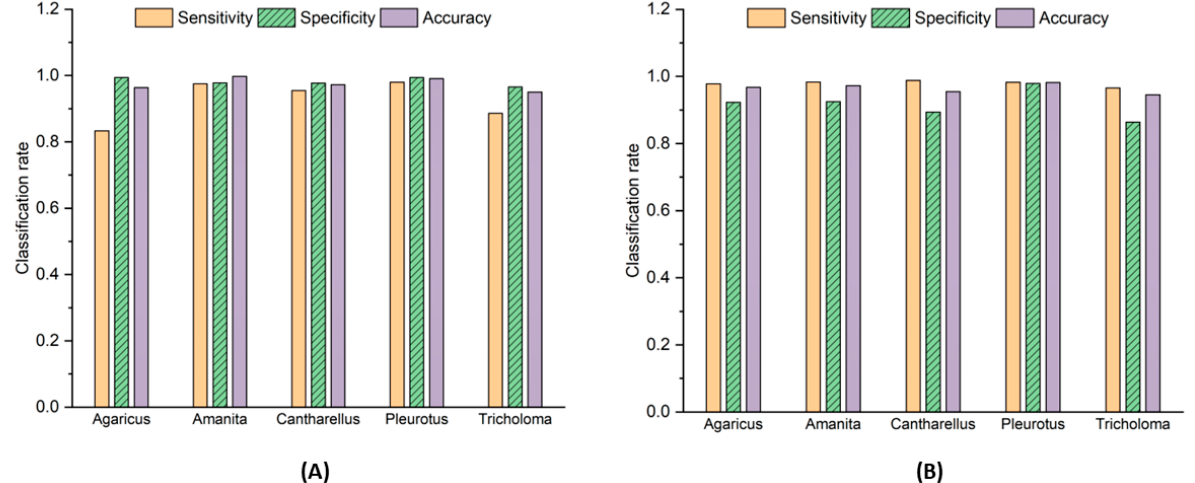
Figure 4. Comparison of sensitivity and specificity for the five classes of Agaricus , Amanita , Cantharellus , Pleutrotus , and Tricholoma . ( A ) Classification rate from laptop training and testing. ( B ) Test results from importing the trained model to the smartphone handset.